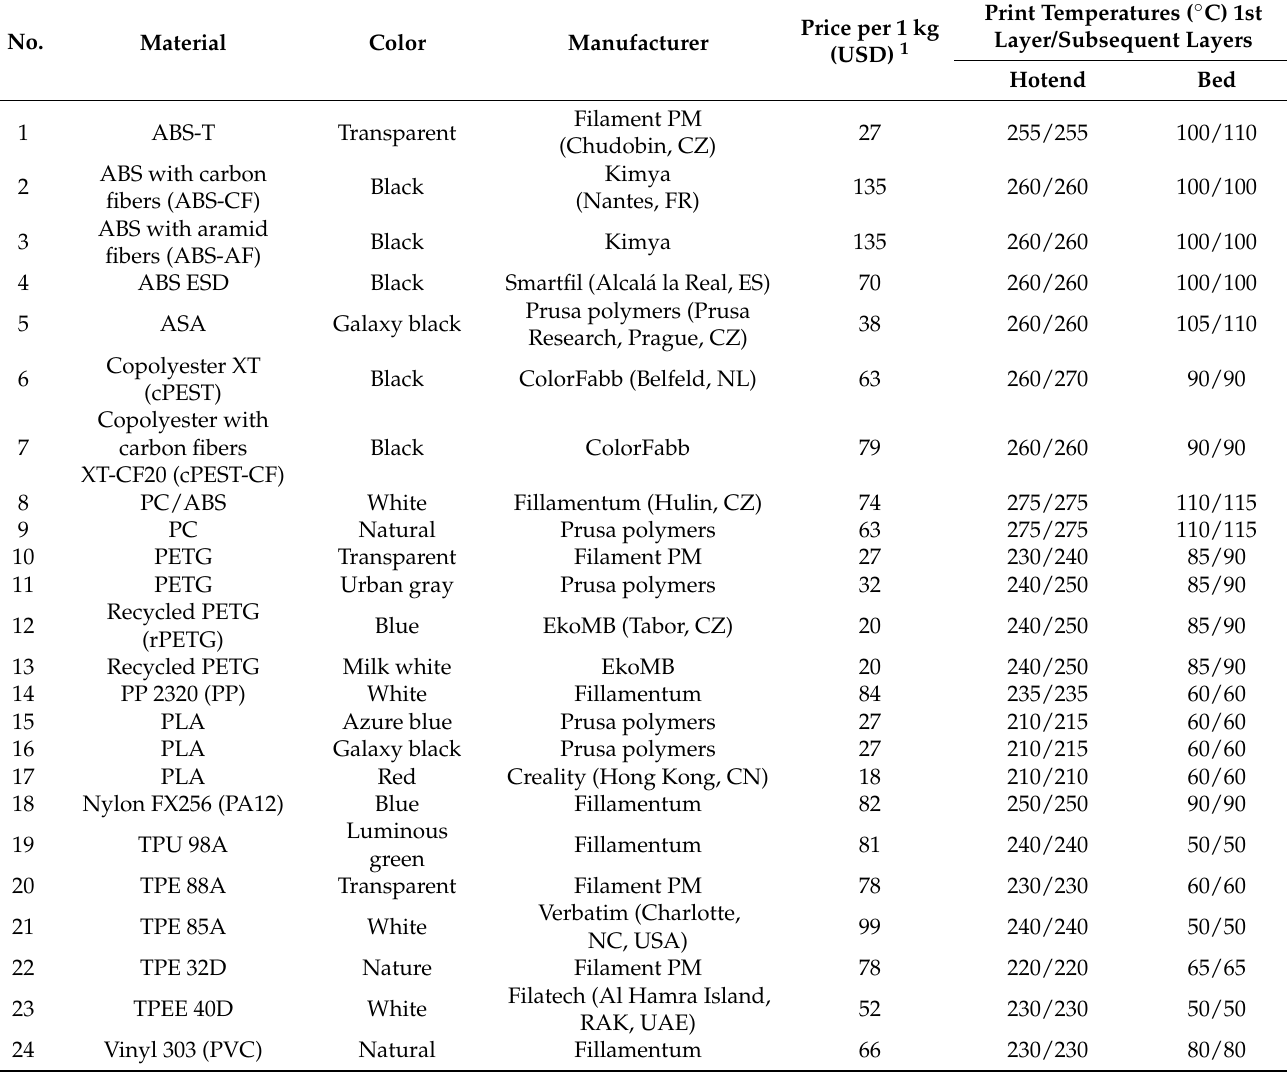
Table 1. Summary of the tested materials and parameters used for manufacturing printed